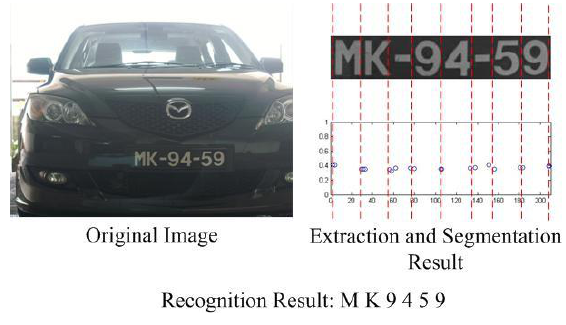
Experimental result with high illumination contrast between background and license